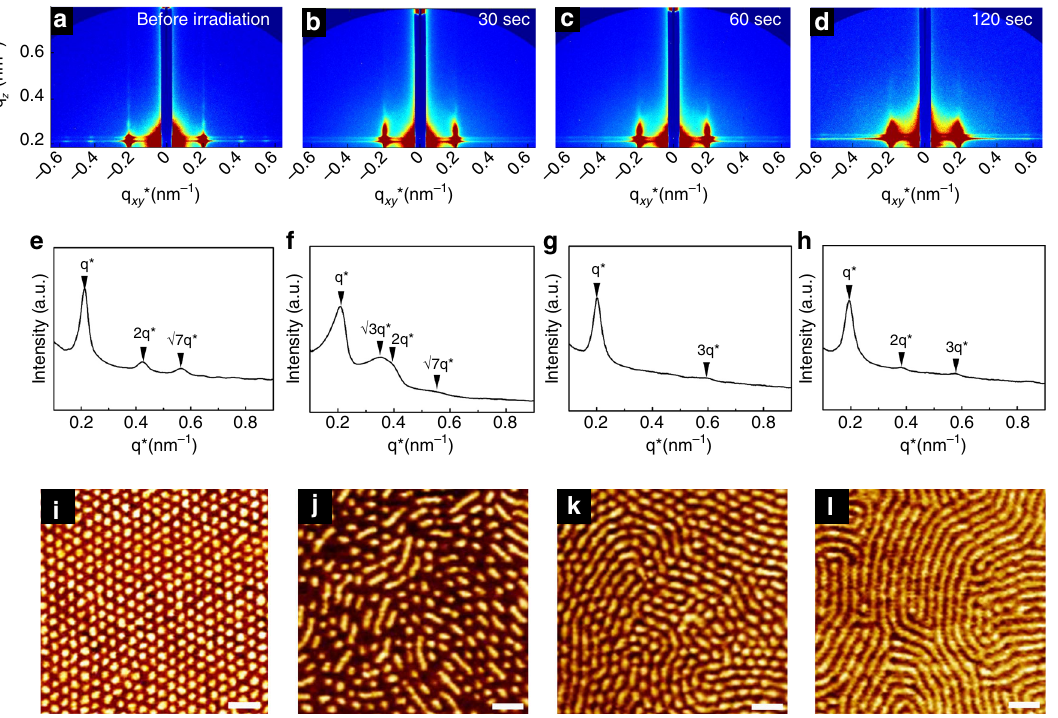
Fig. 3 Thin fi lm morphologies during UV irradiation at 230 °C. a – d GISAXS patterns, e – h the in plane ( q xy ) scans of GISAXS patterns, and i – l phase contrast AFM images at various UV irradiation times. a, e, i : before irradiation; b, f, j : 30 s; c, g, k : 60s; d, h, l : 120s. The thickness of the sample is 57 nm (~2 L 0 ). Scale bar is 100